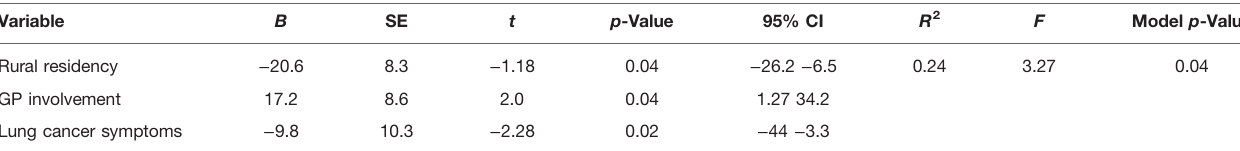
GP, general practitioner; B, unadjusted coef fi cient; SE, standard error; CI, con fi dence